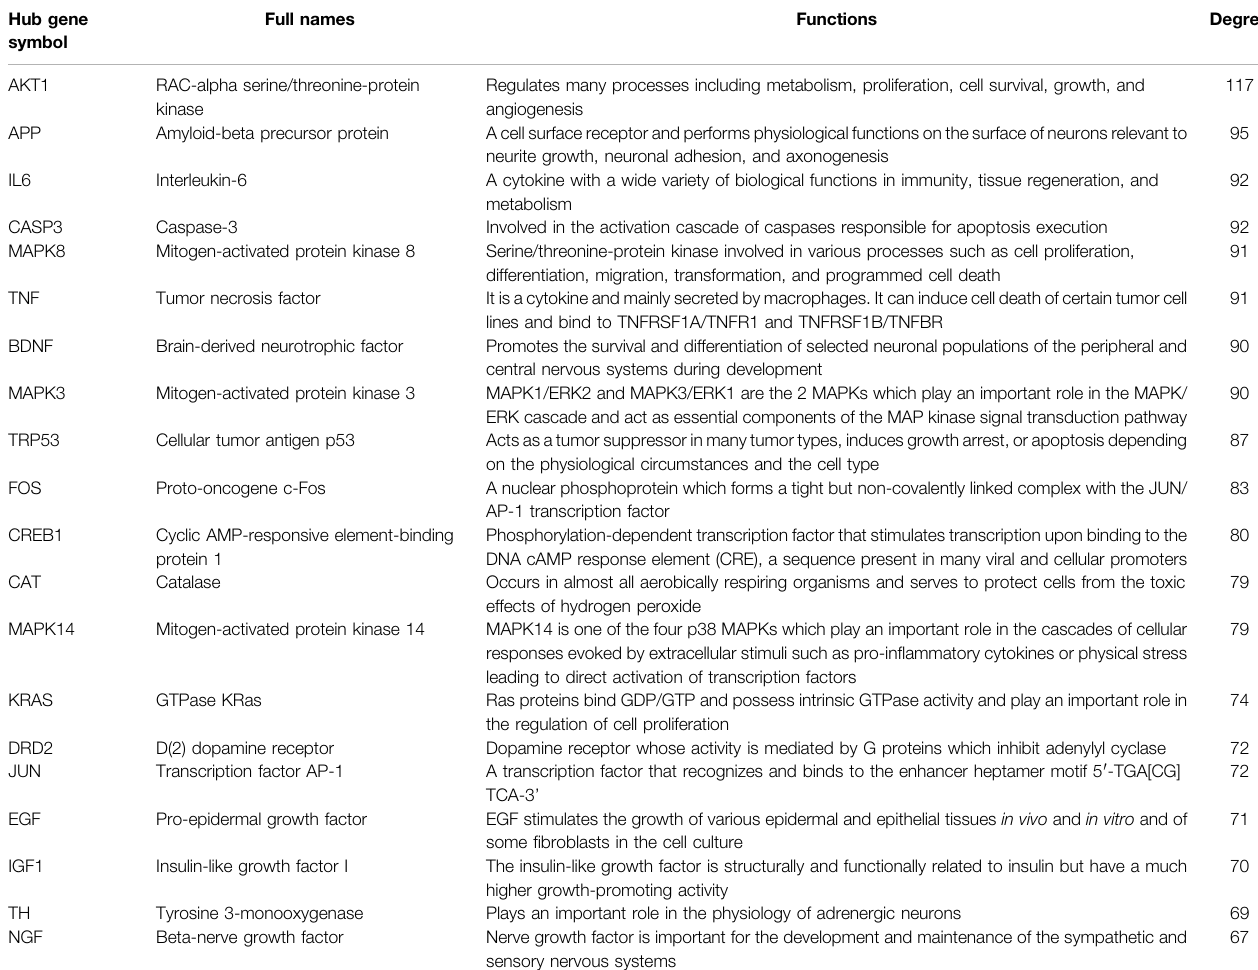
TABLE 1 | Detail information of hub genes involved in the neuroprotective effect of krill oil on METH-induced memory impairment. Hub gene